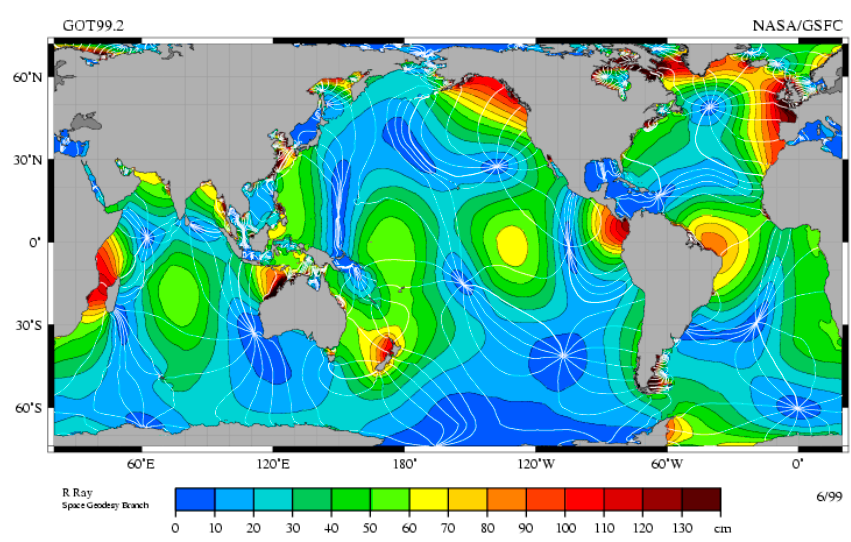
Figure 6. Global map of tidal amplitude [22].